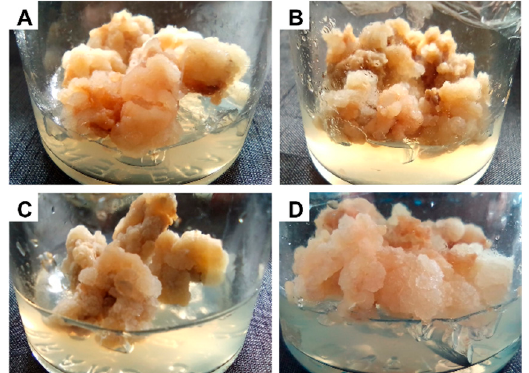
Figure 1. Photographs of A. malaccensis callus 20 days after treatment with elicitors. Callus grew in the presence of elicitor derived from mycelium of F. solani strain GSL1 ( A ), strain GSL2 ( B ), and MeJA ( C ) had similar brownish appearances compared to the control untreated callus ( D ).